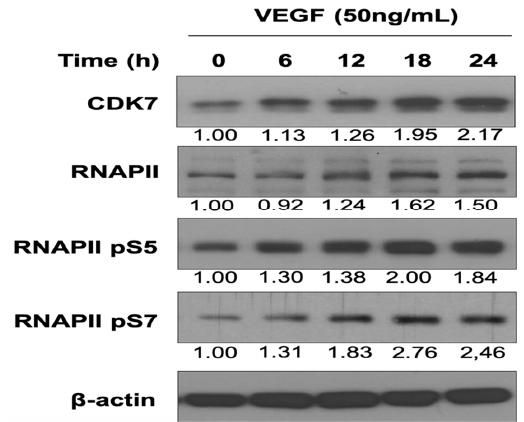
Figure 1. Vascular endothelial growth factor (VEGF) increased Cyclin-dependent kinase 7 (CDK7) and RNA polymerase II (RNAPII) expression and downstream RNAPII phosphorylation at serine 5 and 7 in human umbilical vein endothelial cells (HUVECs). HUVECs were treated with 50 ng/mL VEGF for 6–24 h. The cells were then harvested and subjected to Western blotting analysis using specific CDK7, RNAPII, RNAPII pS5, and RNAPII pS7 antibodies. Numbers under the plots indicate the fold change of protein level relative to their untreated control. Similar results were obtained in at least three independent experiments.